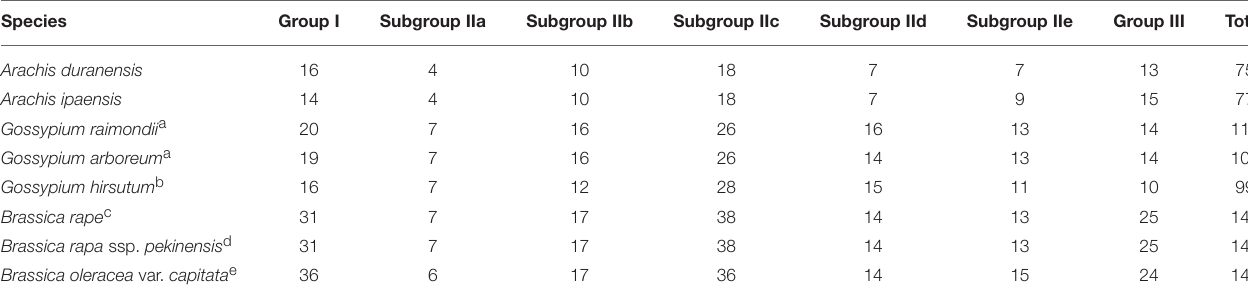
TABLE 1 | Number of WRKY proteins in plants. Species Group